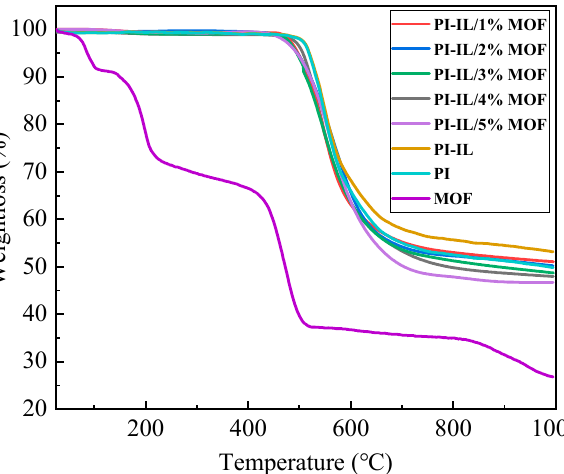
Figure 5. TGA curve of MOF, PI, PI-IL and PI-IL/x% MOF membranes.